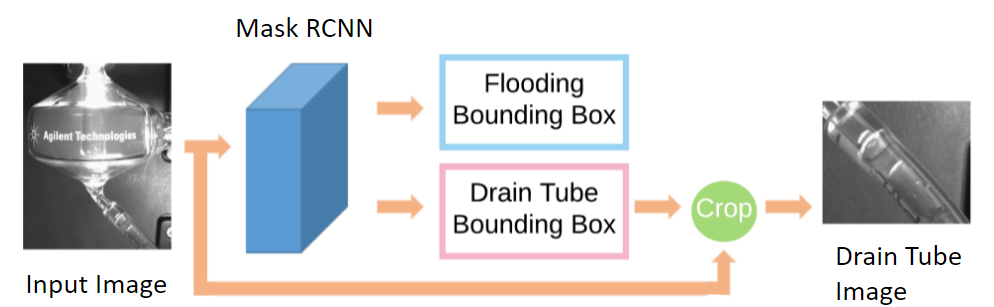
Figure 3. The Mask RCNN stage of the flooding detection. First, we use Mask RCNN to generate bounding boxes for flooding and the drain tube. Then we crop the drain tube region from the input image. The drain tube image and the flooding bounding box enter the next stage of flooding